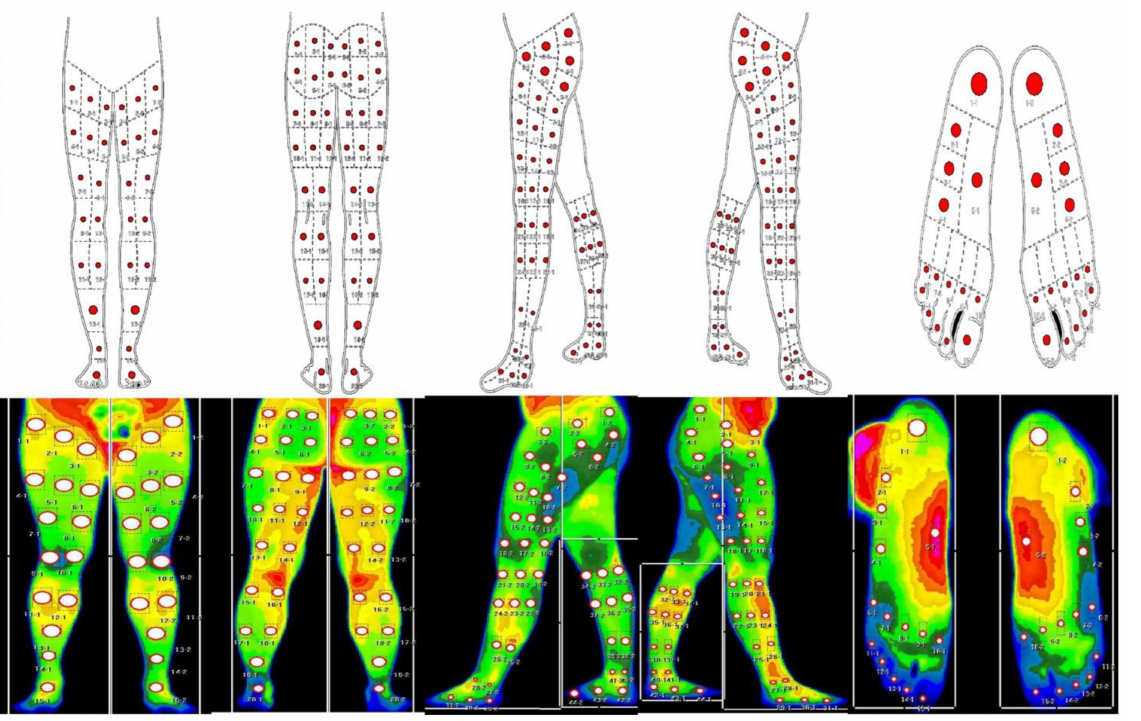
Figure 1. Diagram and practical imaging of regions of interest in the front, lateral-side, back, and sole areas of the